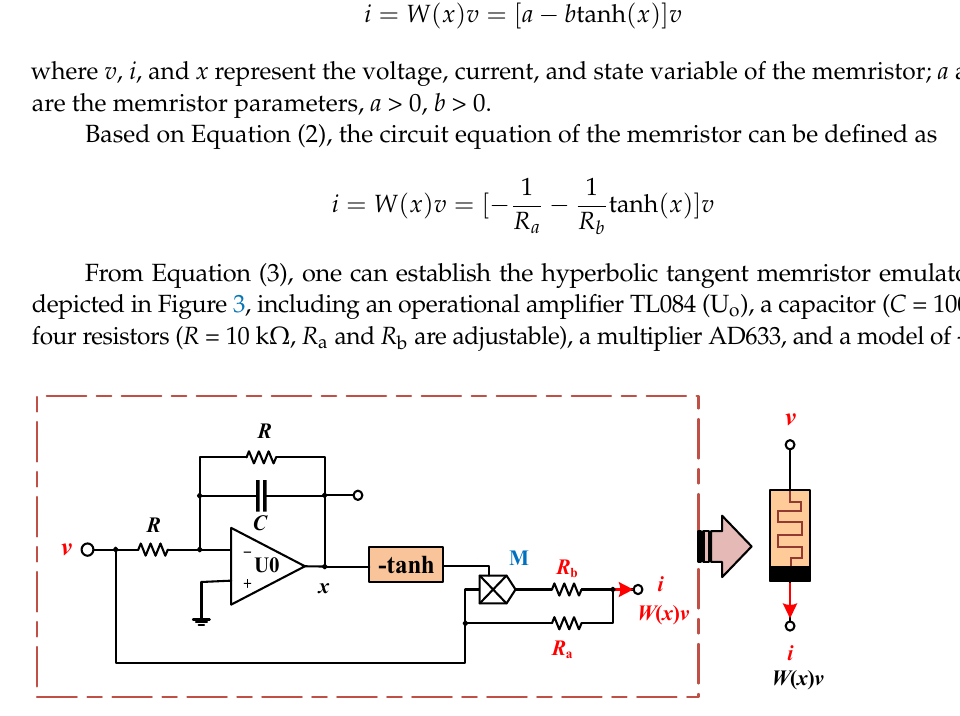
Figure 3. Hyperbolic tangent memristor emulator.